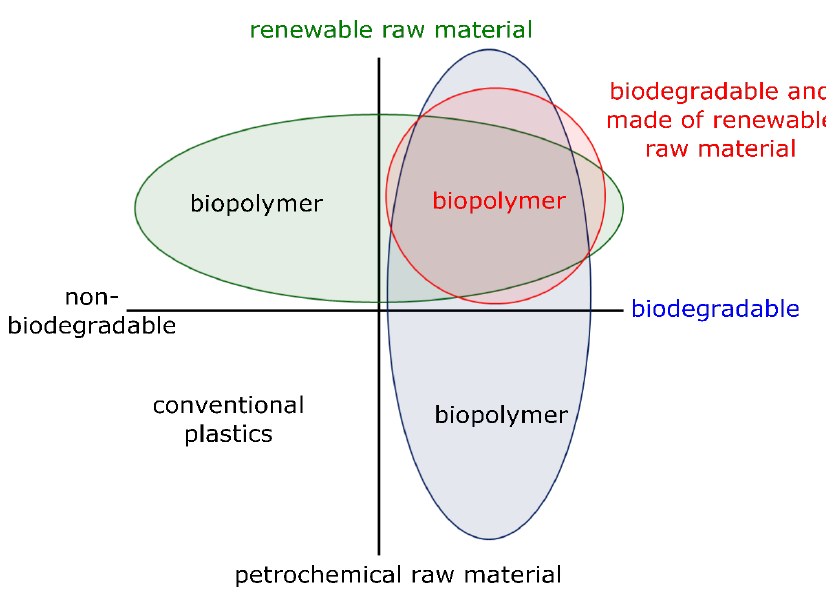
Figure 1. Definition for biopolymers, including the stringent definition on the upper right, modified after [4].